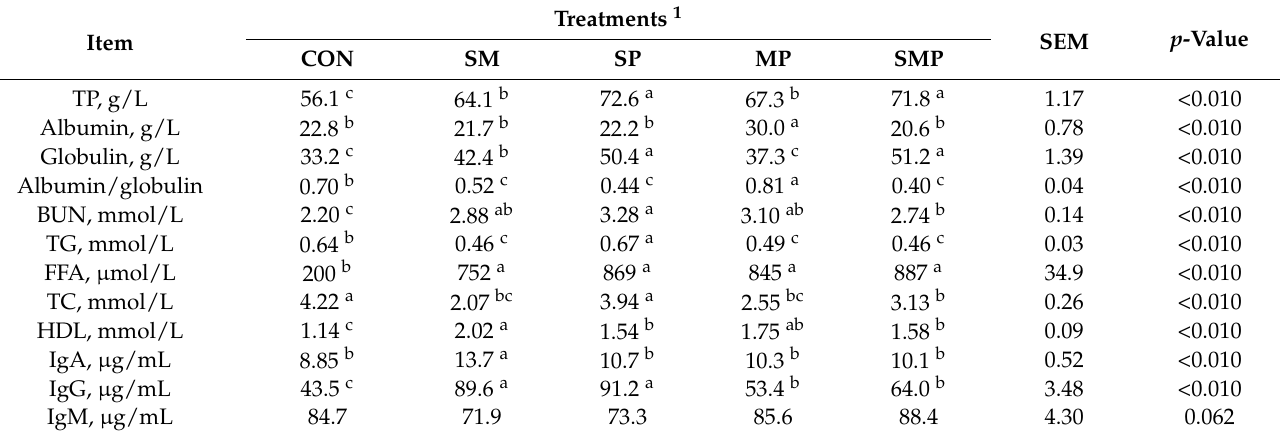
Table 5. Effects of supplementing the diets with different combinations of SB, MCFAs, and omega − 3 PUFA on the plasma biochemical index of suckling